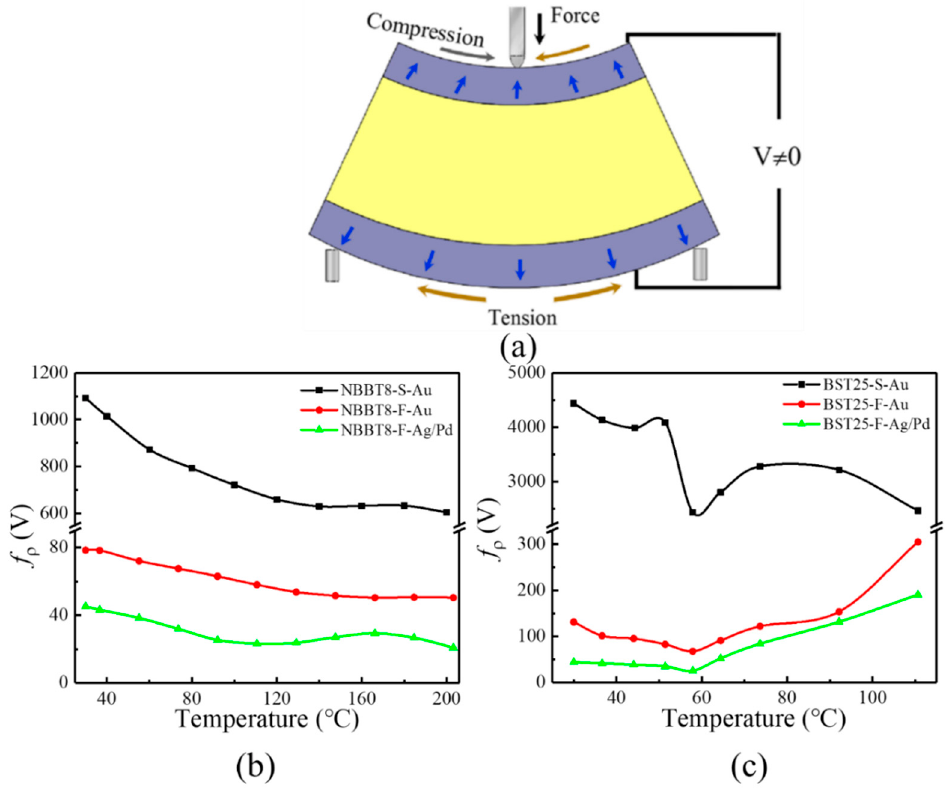
Figure 10. ( a ) Schematic of the contribution of the spontaneously polarized surface to the measured flexoelectric coefficient under bending. Reprinted with permission from [45]. Copyright 2018 American Physical Society. ( b , c ) The flexocoupling coefficients of NBBT8 and BST25 ceramics after sputtering (S) or fired (F)-on electrodes. Reprinted with permission from [42]. Copyright 2021 AIP Publishing. f ρ is the effective flexoelectric coefficient.